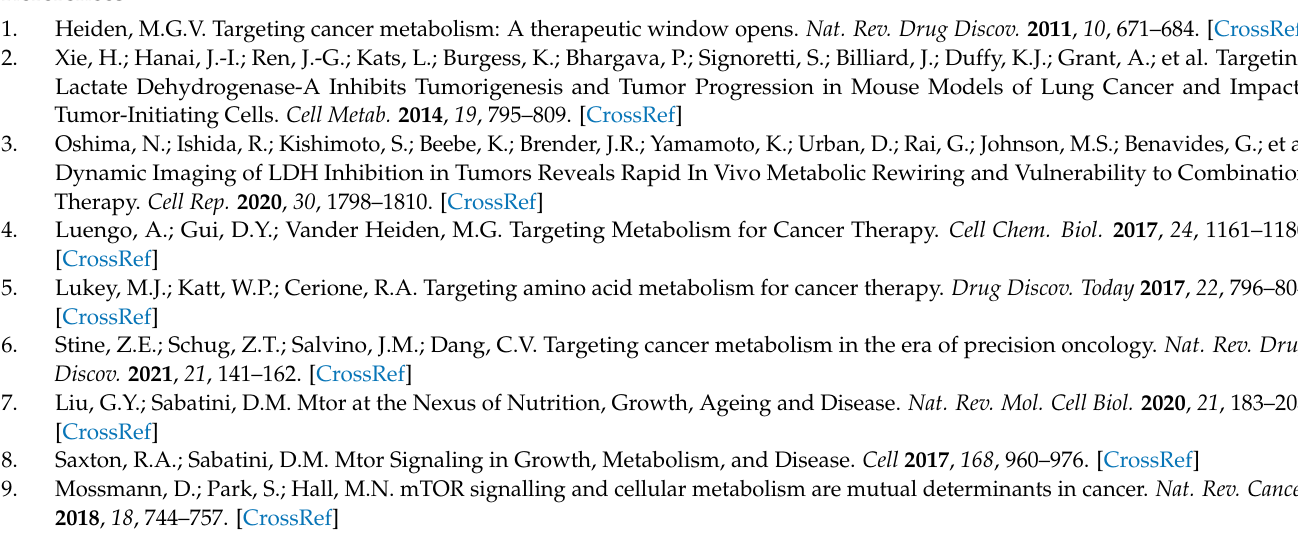
Figure S3: Group 1 of amino acid deprivations causes metabolic, oxidative, and nutritional stress; Figure S4: Group 2 of amino acid deprivations causes solely nutritional stress; Figure S5: Group 3 of amino acid deprivations causes solely oxidative stress; Figure S6: Sestrin2-dependent regulation of mTORC1 upon amino acid